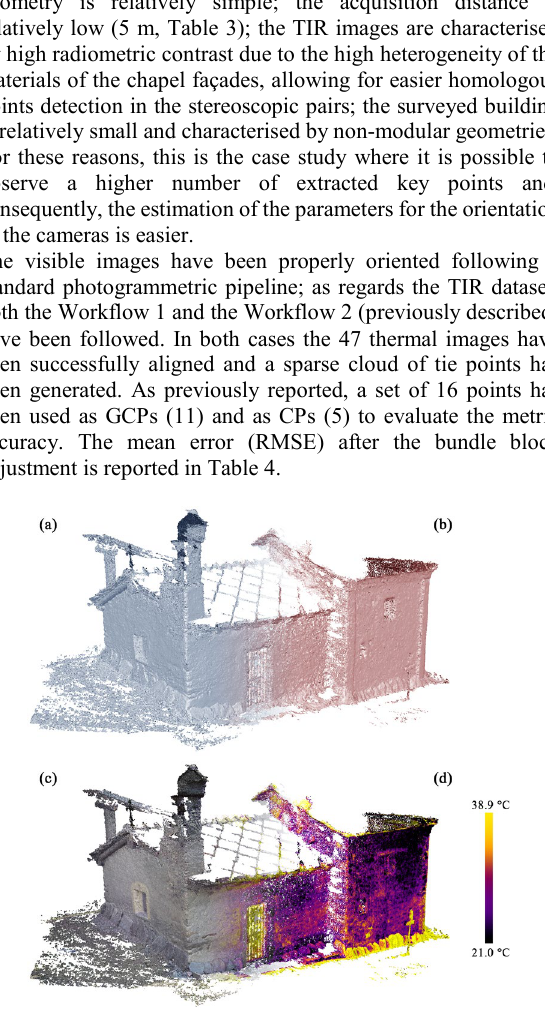
Figure 7 . Molini Allioni chapel: (a) dense point cloud derived from the visible dataset; (b) dense point cloud derived from thermal dataset; (c) coloured dense point cloud derived from visible dataset; (d) coloured dense point cloud derived from